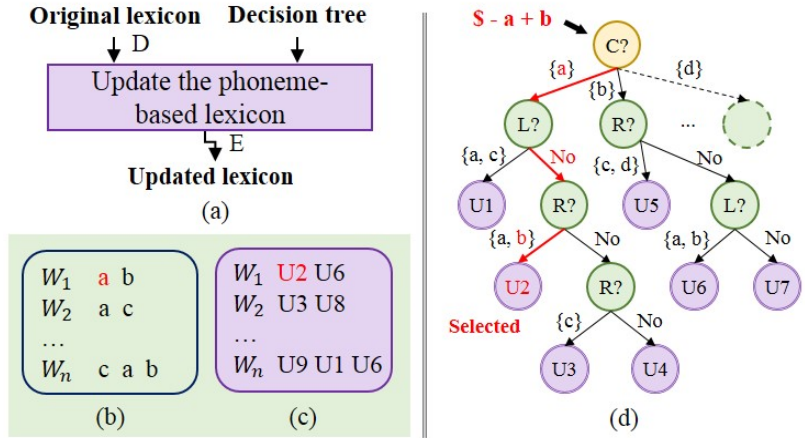
Figure 4. Block diagram and an example of the lexicon update. ( a ) Block diagram of the lexicon update; ( b ) phoneme-based lexicon given at point D; ( c ) proposed lexicon obtained at point E; ( d ) example of the lexicon update using CD phoneme “$ - a + b”.